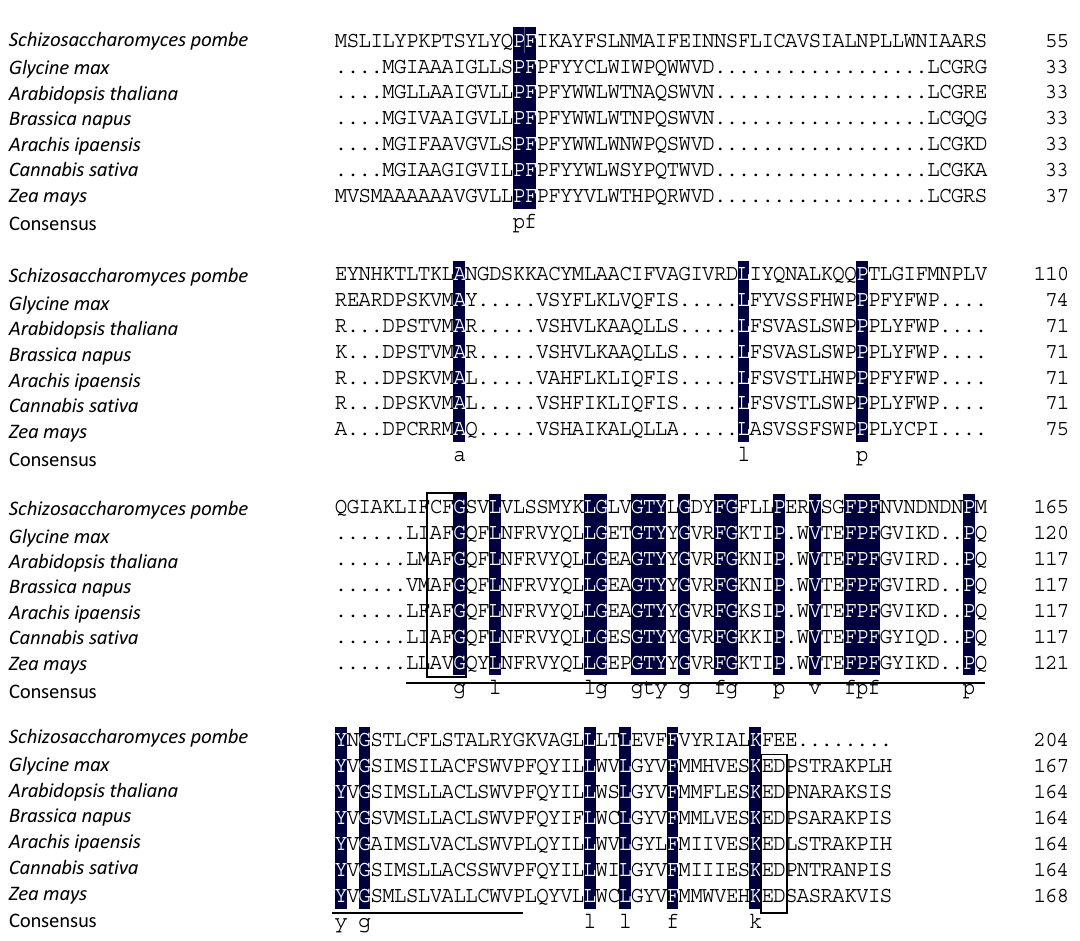
Figure 5. Sequence alignments of seven phospholipid methyltransferase (PLMT) proteins including Schizosaccharomyces pombe (AF004112.1), Glycine max (NM_001249156.2), Arabidopsis thaliana (NP_565246.1), Brassica napus (XP_013674943.1), Arachis ipaensis (XP_016176048.1), Cannabis sativa (KAF4387675.1), and Zea mays (PWZ27952.1). The conserved amino acids among the PLMTs are indicated by a dark background. The underlined regions represent the predicted phospholipid binding sites. The proposed binding sites (i.e., AFG and ED) for S-adenosyl-L-methionine (SAM) are indicated by two boxes.